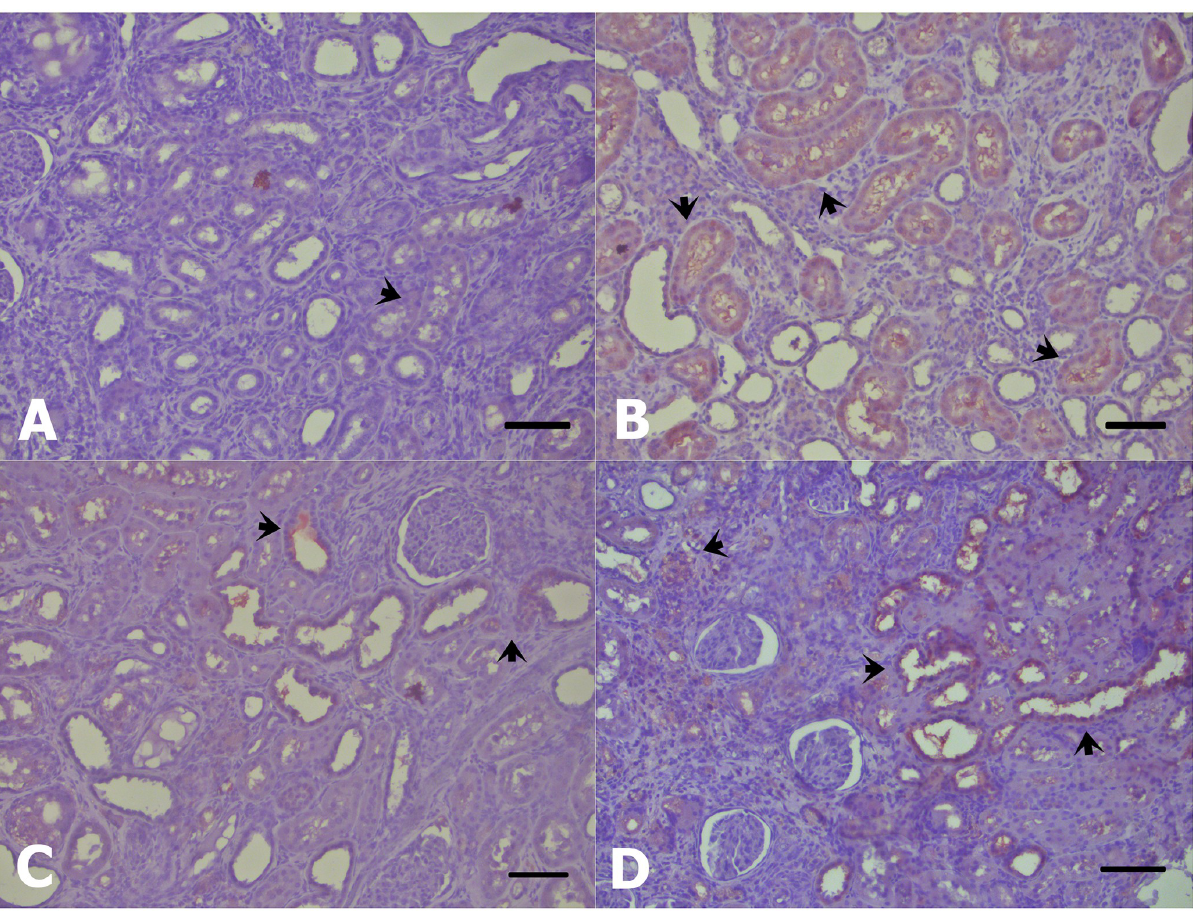
Fig 3. Immunopositive staining of SOD; (A) CKD, (B) CKD-Pre and GPx; (C) CKD, (D) CKD-Pre activities (arrowheads) in adenine-induced CKD. Scale bars: (A, B, C, D); 220 μ